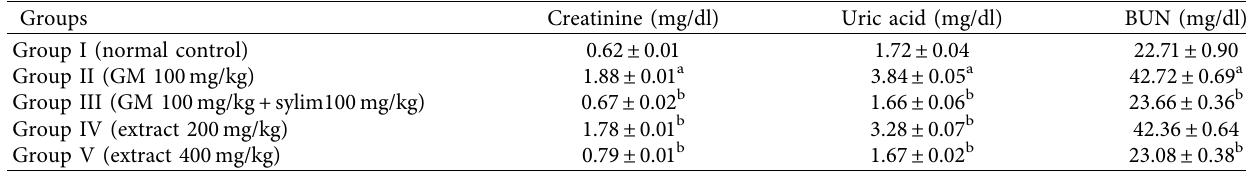
Table 3: The effects of A . africanus root extract on gentamicin-induced nephrotoxic mice.